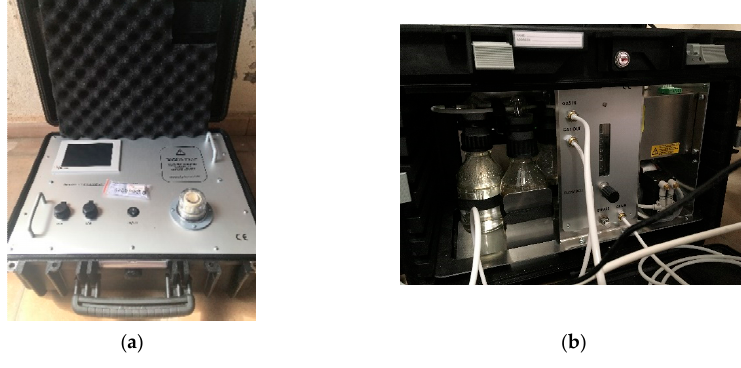
Figure 8. Gas Chromatograph ( a ) and chiller ( b ).